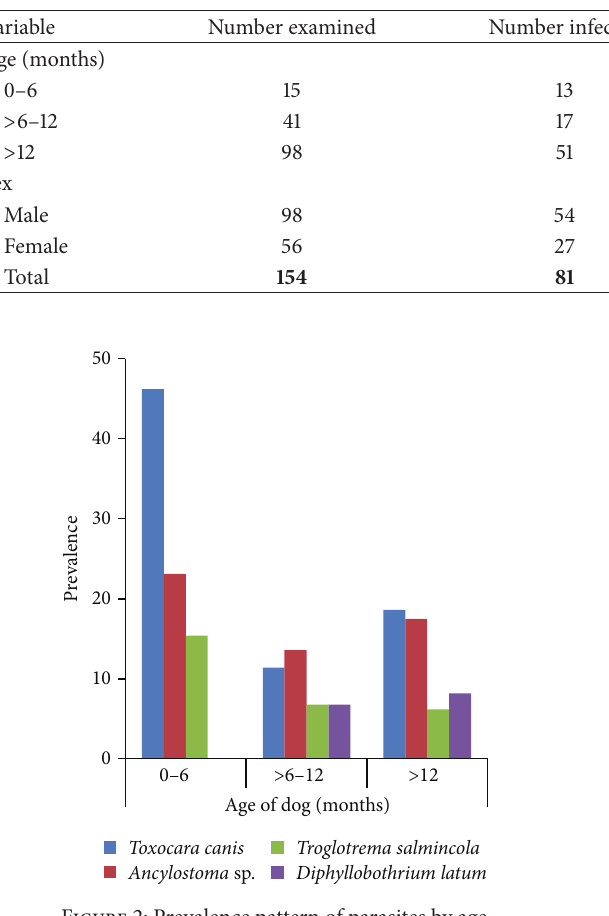
Figure 2: Prevalence pattern of parasites by age.